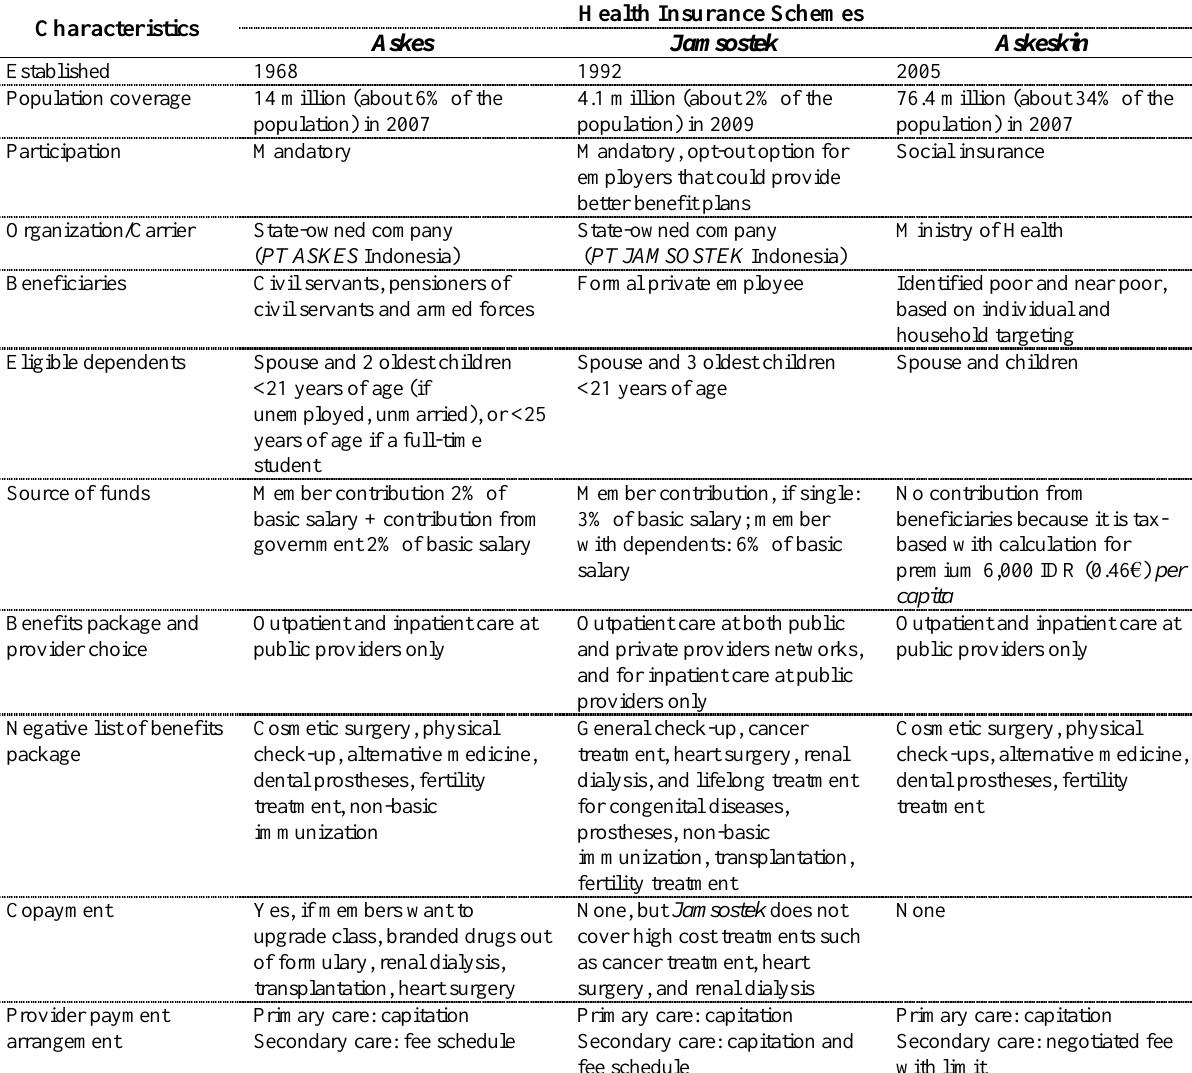
Table 1. Main features of the three health insurance schemes in